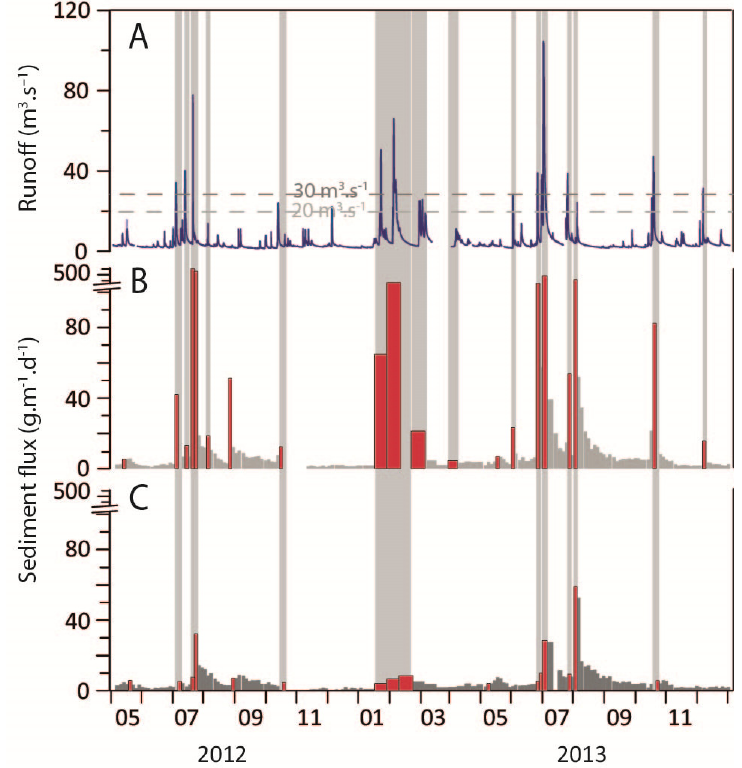
Figure 10. Results from the river-lake monitoring campaign developed at Lake Mondsee (Austria) combining gauge data ( A ), proximal ( B ) and distal ( C ) sediment traps. The red colored samples highlight sediment flux peaks exceeding the median sediment flux (4 g · m − 2 · d − 1 ) and increasing by 50% compared to the previous sample. The grey bars highlight sediment flux peaks synchronous with high discharge. The dashed lines show that Figure 10. m 3 · s − 1 at proximal locations and 30 m 3 · s − 1 at distal locations for triggering peaks in sediment flux that will result in the formation of flood layers (modified after Kämpf et al., 2015 [28]).